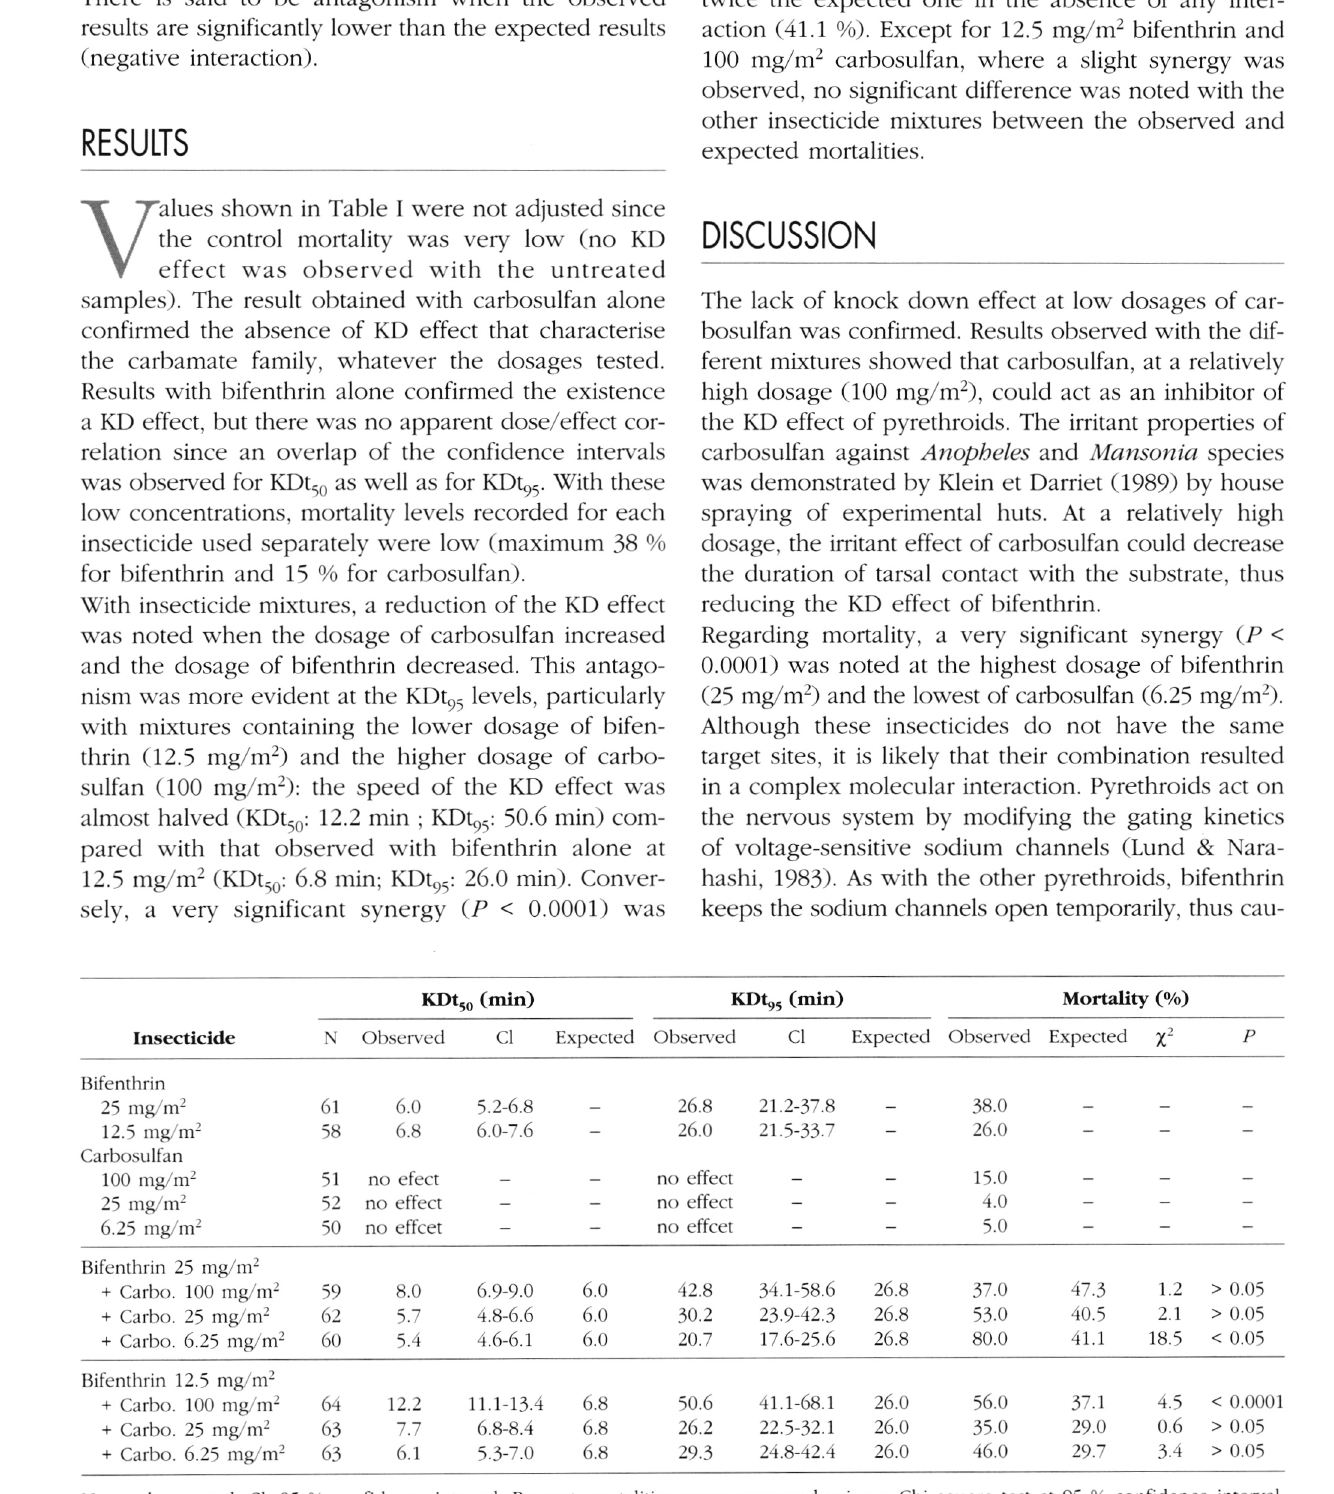
Table I. - Compared activity of bifenthrin and carbosulfan formulations, alone and in association, against susceptible Anopheles gambiae. Parasite, 2002, 9,